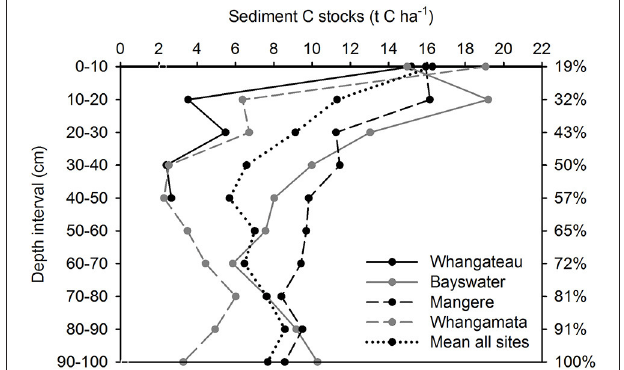
FIGURE 3 | Vertical distribution of sediment total nitrogen stocks to 100cm. Values are t N ha − 1 for each 10cm depth interval. The cumulative percentage of sediment nitrogen captured at increasing depths throughout the sediment column (based on mean from all sites; relative to cores to 100cm) is shown on the right side of the